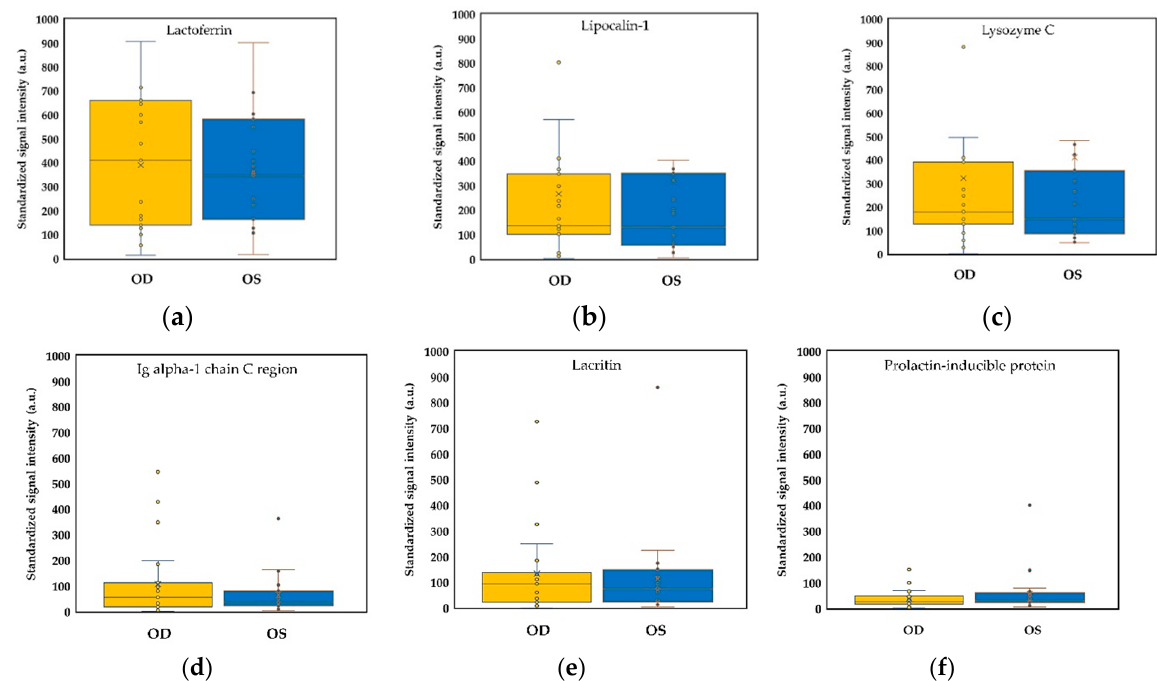
Figure 3. Comparison of lactoferrin-corrected standardized signals for six always presented molecules in binocular tear samples of dry eye subjects ( N = 23). ( a ) lactoferrin ( p = 0.8422); ( b ) lipocalin-1 ( p = 0.6221); ( c ) lysozyme C ( p = 0.9168); ( d ) Immunoglobulin alpha-1 chain C region ( p = 0.4820); ( e ) lacritin ( p = 0.5803); and ( f ) prolactin-inducible protein ( p = 0.3604). Abbreviation: Ig, immunoglobulin.